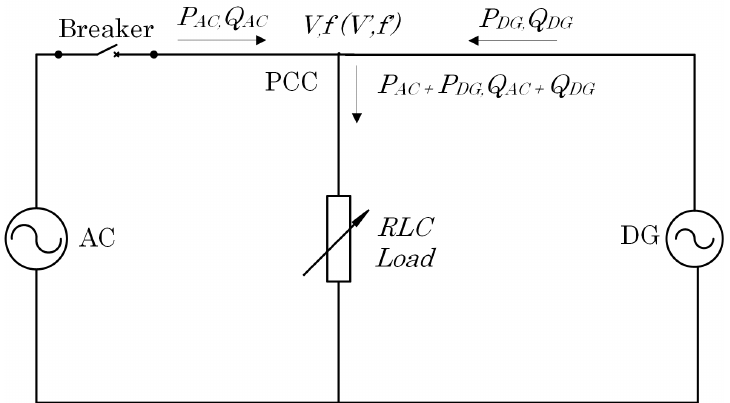
Figure 2. AC grid in normal and islanding